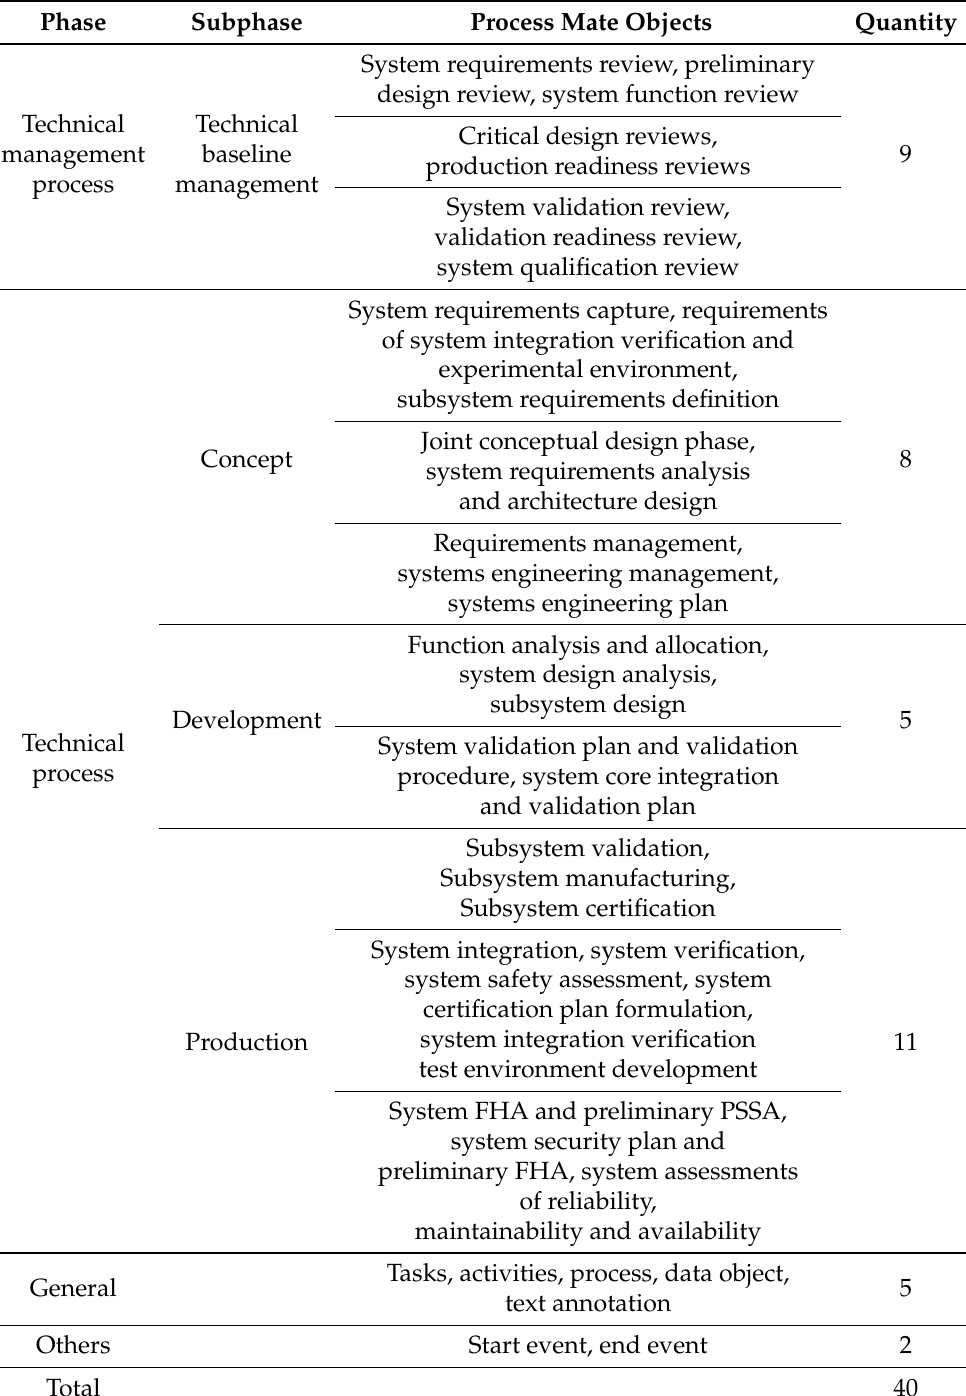
Table 1. Object metamodels for process modeling.